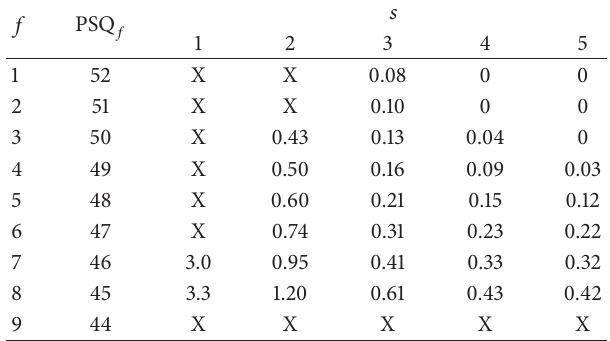
Table 2: The results of TL 𝑓𝑠 under different optimized solution